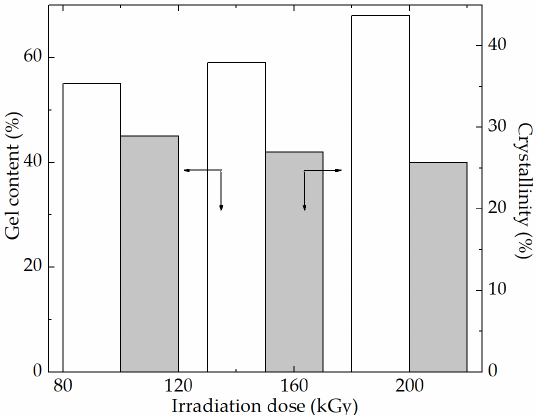
Figure 3. Correlation between the gel fraction and crystallinity in irradiated HDPE/CB